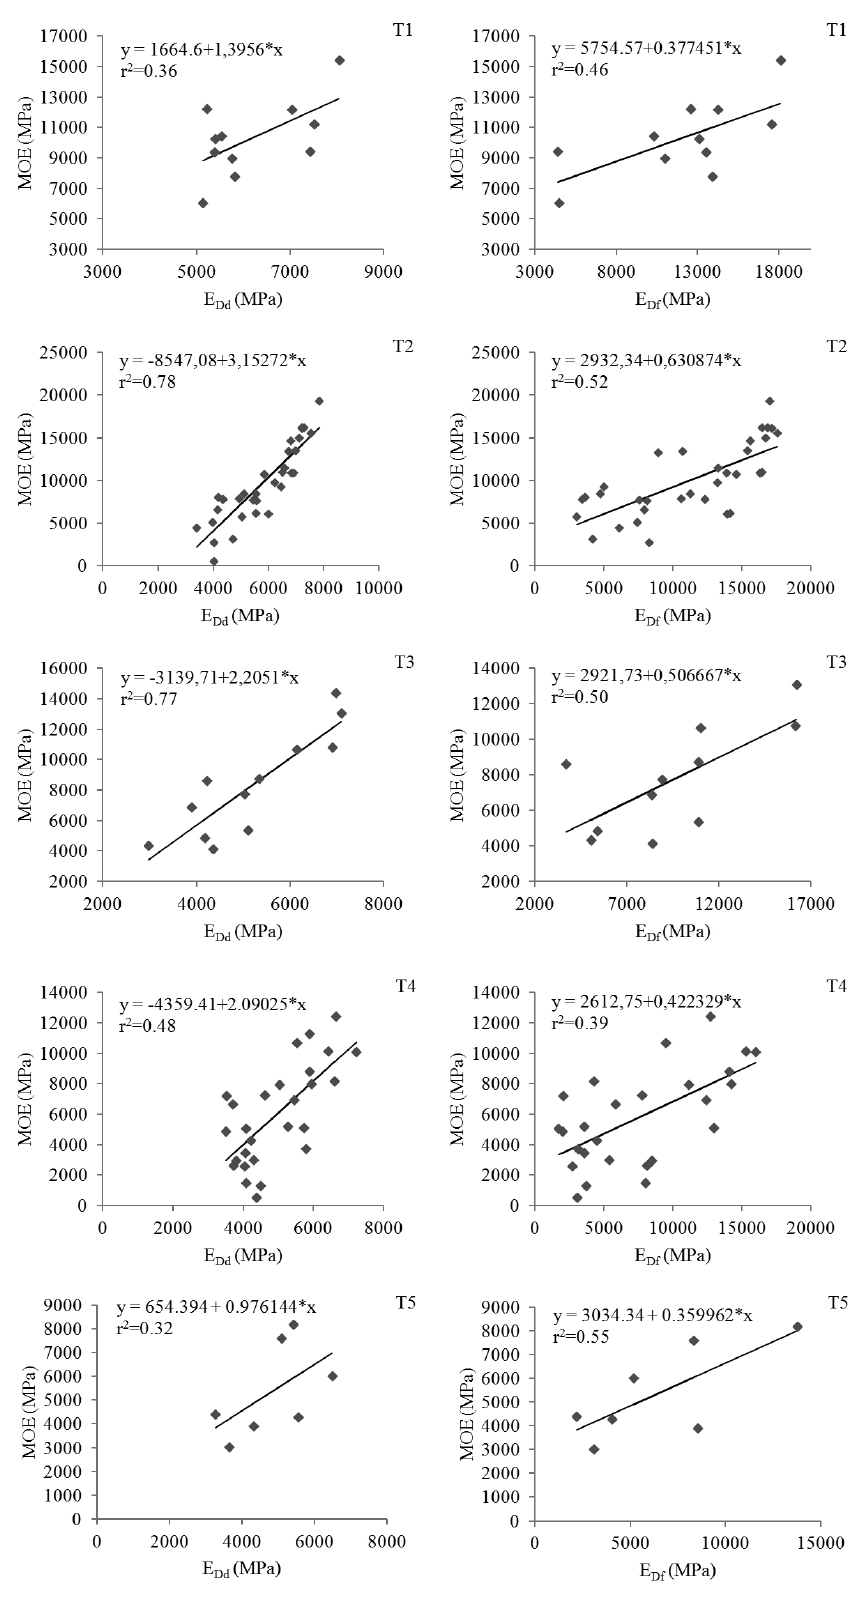
Figure 5. Linear regression models. Points = observed data; Line = Calculated data; y = MOE –modulus of elasticity; x = E modulus of elasticity (dry point transducer) and E